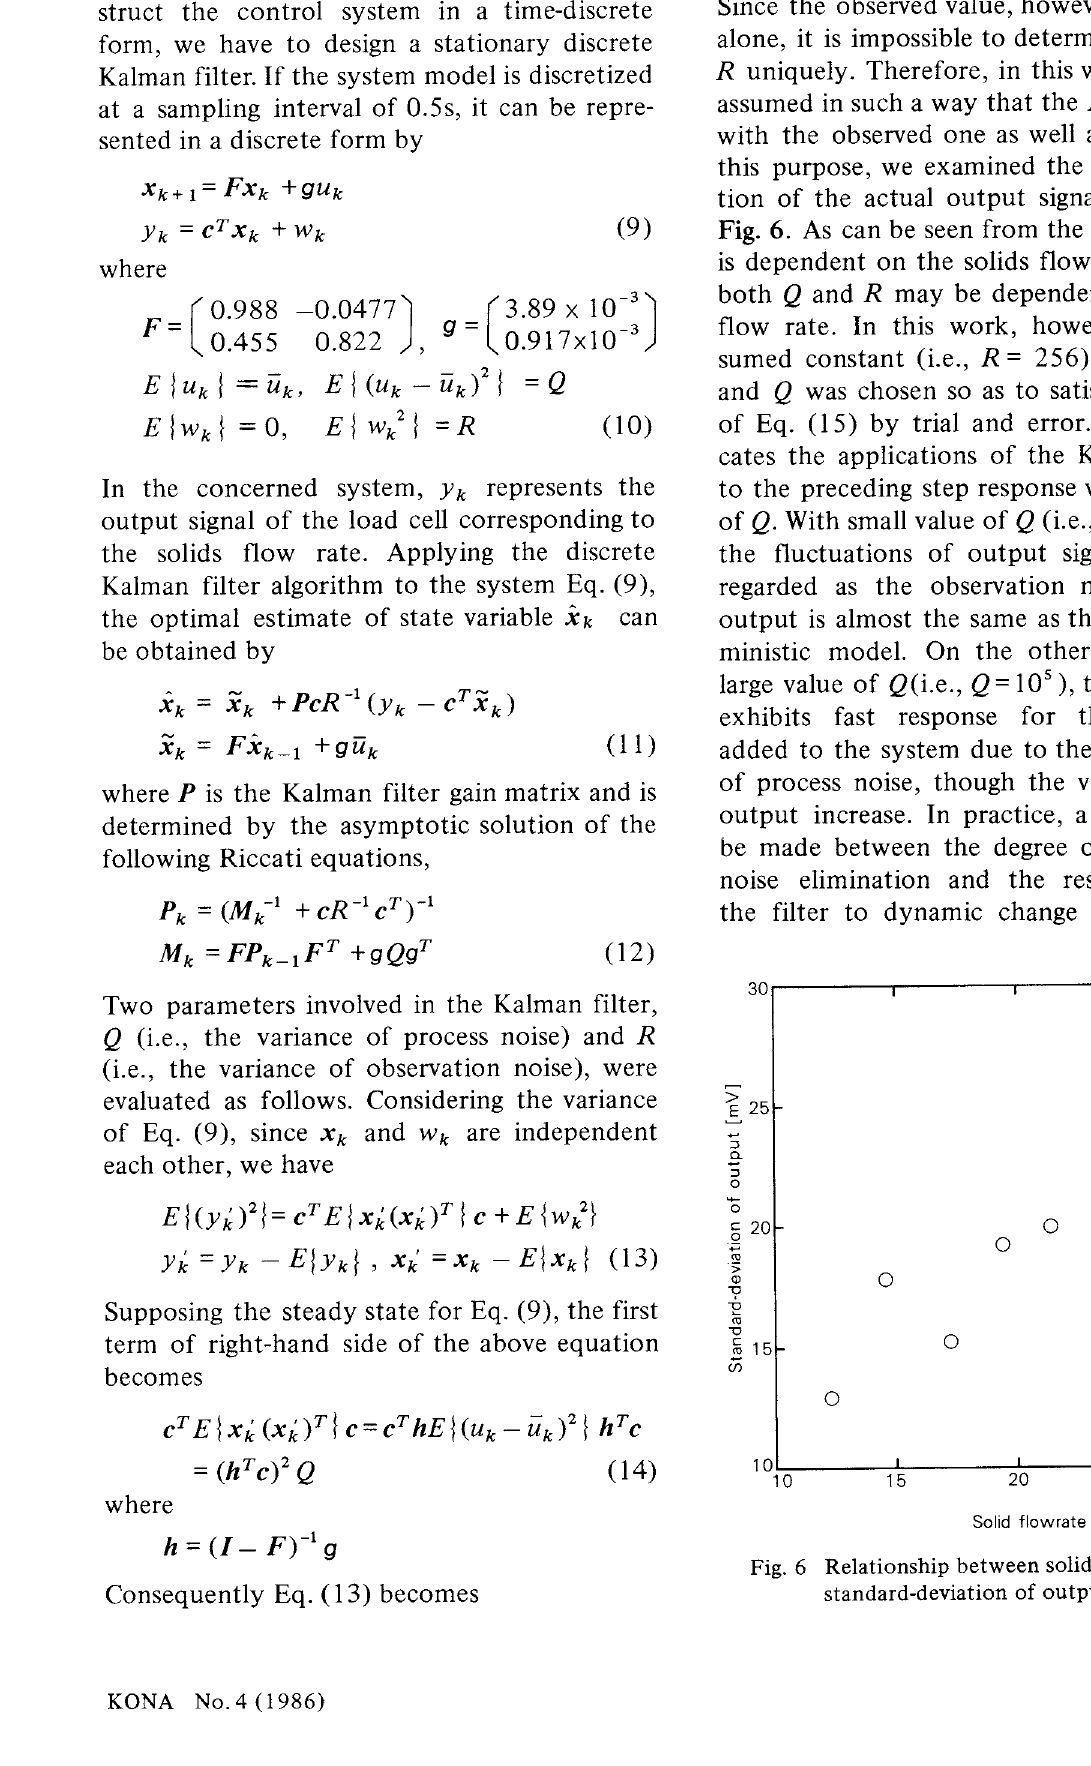
Fig. 6 Relationship between solids flow rate and standard-deviation of